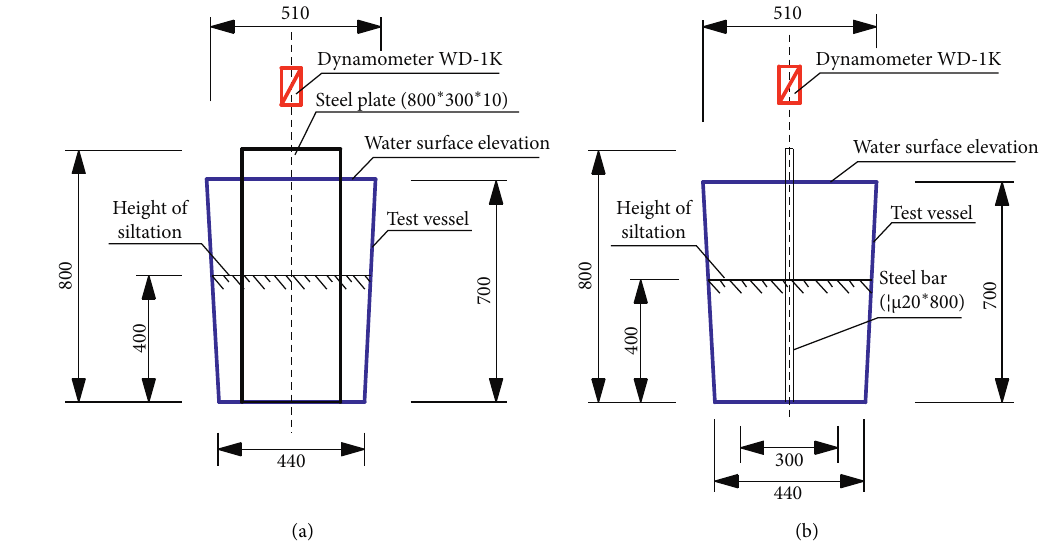
Figure 1: The schematic diagram of the test model. Table 1: Test parameters of a single blockage.